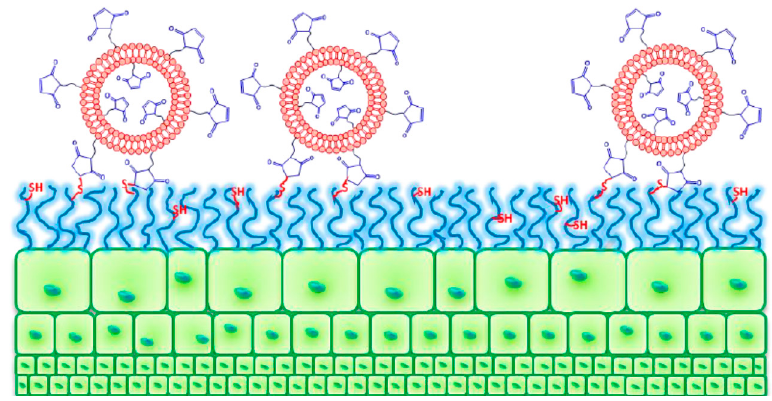
Figure 6. Maleimide-functionalized PEGylated liposomes showing mucoadhesive properties thanks to the covalent linkages with thiol-groups present in mucins. Reproduced with permission from [97]. Copyright © 2018 Elsevier.